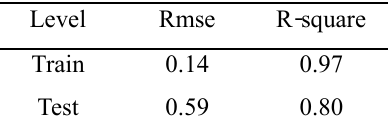
The results of model evaluation.